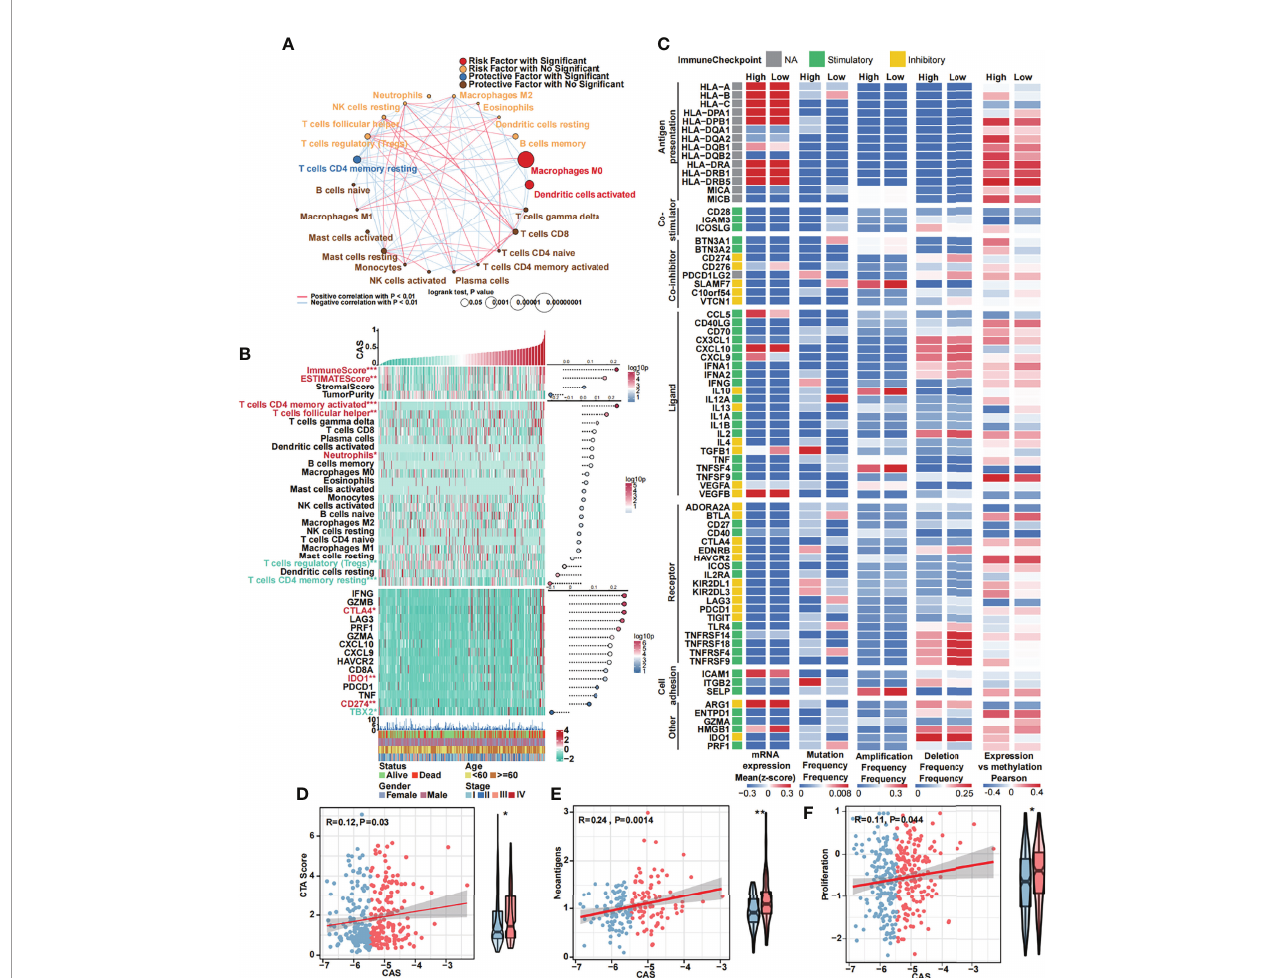
FIGURE 6 | Immune analyses of the constructed ANN model. (A) Cox regression and Pearson ’ s correlation analysis of 22 TICs. (B) The expression and Pearson ’ s correlation of immune, ESTIMATE, stromal score, tumor purity, TICs, checkpoints, and immunocompetences of each sample are illustrated in a heatmap. (C) Multi- omics analysis of 75 immunomodulators between high- and low-CAS samples. (D) The Pearson ’ s correlation between the CTA score and CAS and the expression of the CTA score in high- and low-CAS samples. (E) The Pearson ’ s correlation between neoantigens and CAS, and the expression of neoantigens in high- and low- CAS samples. (F) The Pearson ’ s correlation between proliferation and CAS, and the expression of proliferation in high- and low-CAS